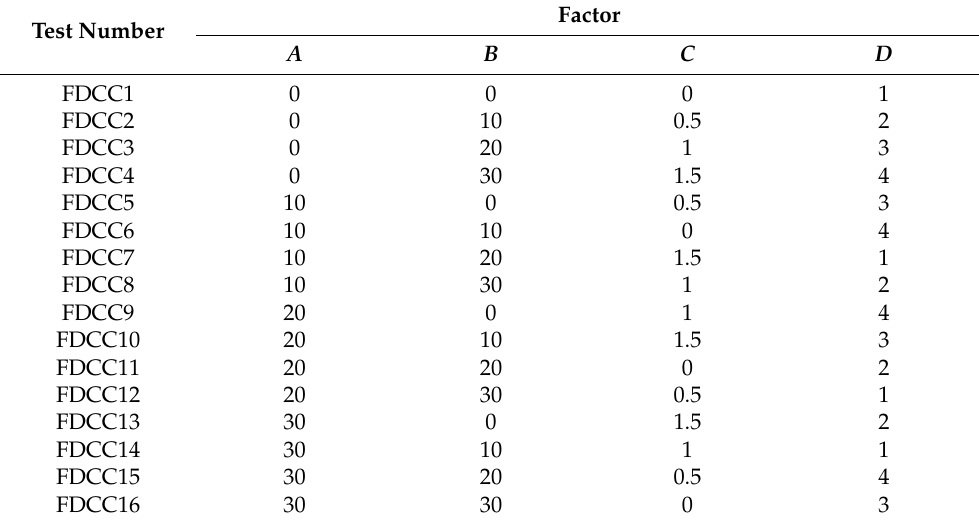
Table 5. The orthogonal test.